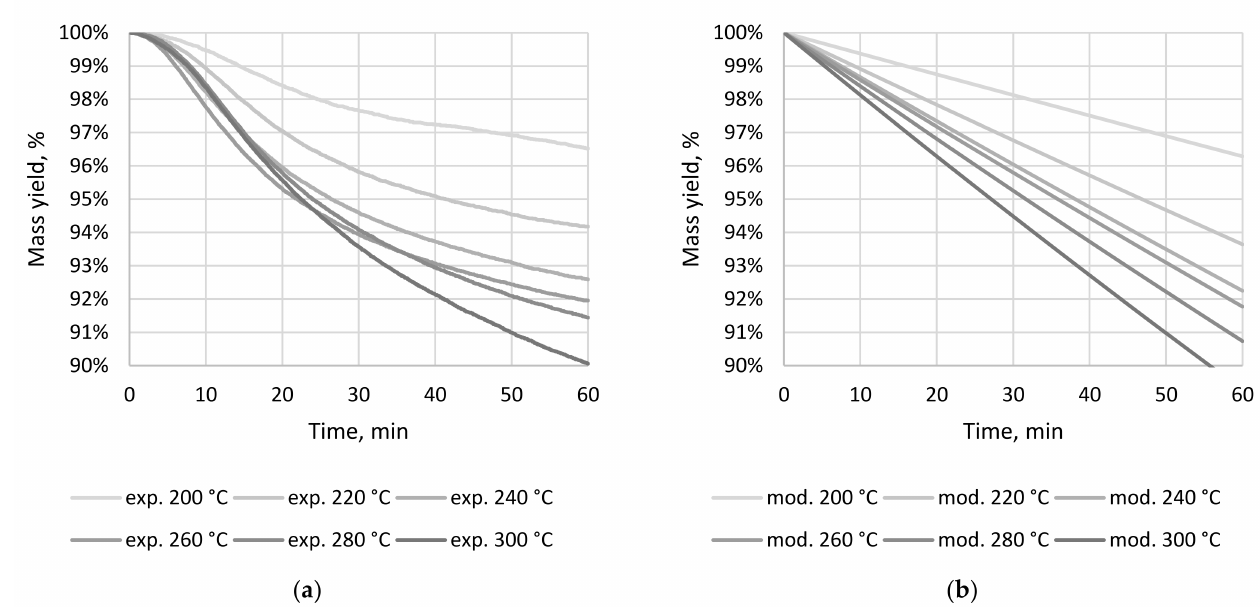
Figure A2. Results of macro-TGA, the effect of isothermal temperatures in time ( a ) experimental data, ( b ) lifetime prediction.